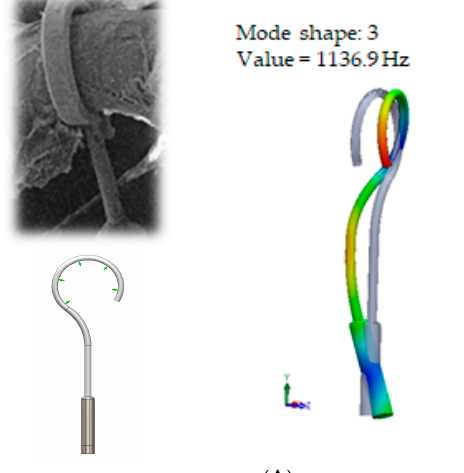
( B ) Figure 6. The results of modal analysis of fixing the standard stapes prosthesis on the incus long process and in cochleostomy. ( A ) target constraining of prosthesis, ( B ) over-constraining of the pros- thesis. In Figure 6A presents standard/target constraining of the standard prosthesis: tight crimping of the long process and sliding of the bottom part of the prosthesis. Here, it can be observed that the third mode exhibits twisting mainly around the axis of the long pro- cess. In Figure 6B presents the over-stretched prosthesis. In this case, the standard pros- thesis is constrained as a cord due to the over-constrained crimping of the stapes long process and tight attachment to the footplate (when the prosthesis bends, it loses mobility,